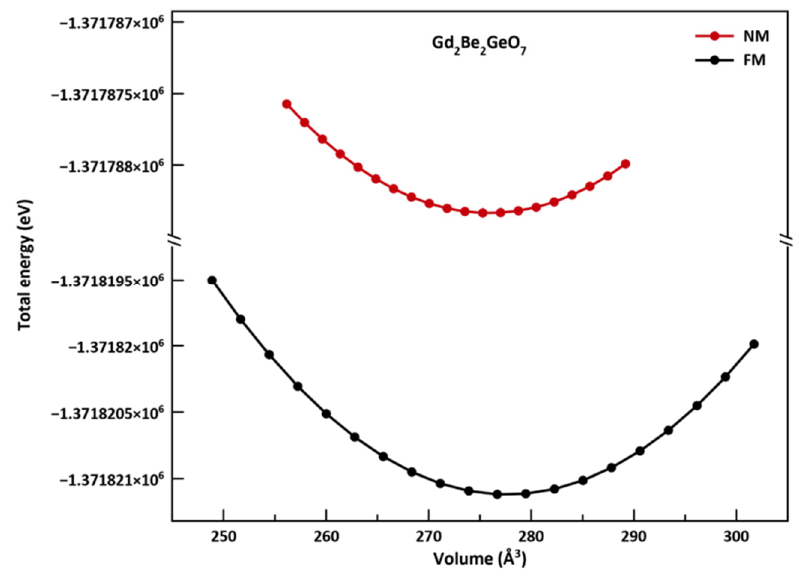
Figure 2. The total energy versus the volume for the ferromagnetic and non-magnetic Gd 2 Be 2 GeO 7 compound . Table 1. Lattice constants a and c, bulk modulus B 0 , and its pressure derivative B’ parameters opti- mization in both ferromagnetic (FM) and nonmagnetic orders (NM). For comparison, experimental and other theoretical values are included [18,19].